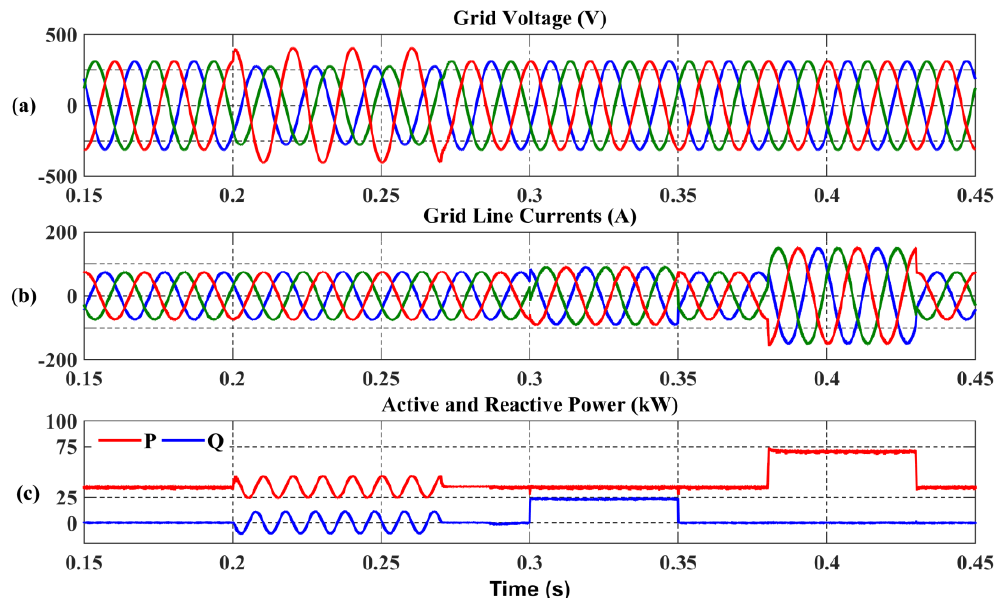
Figure 8. Simulation B results with dual positive- and negative-sequence controllers: ( a ) grid voltage (V) (red: phase-A, blue: phase-B, green: phase-C); ( b ) grid currents (A) (red: phase-A, blue: phase-B, green: phase-C); and ( c ) P g (kW) and Q g (kVAr).